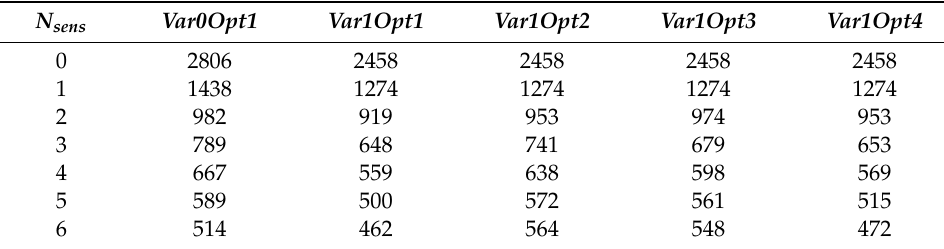
Table 2. Simulation results in terms of exposed population from the four optimizations for sensor placement in the Parete WDN, considering N sens up to